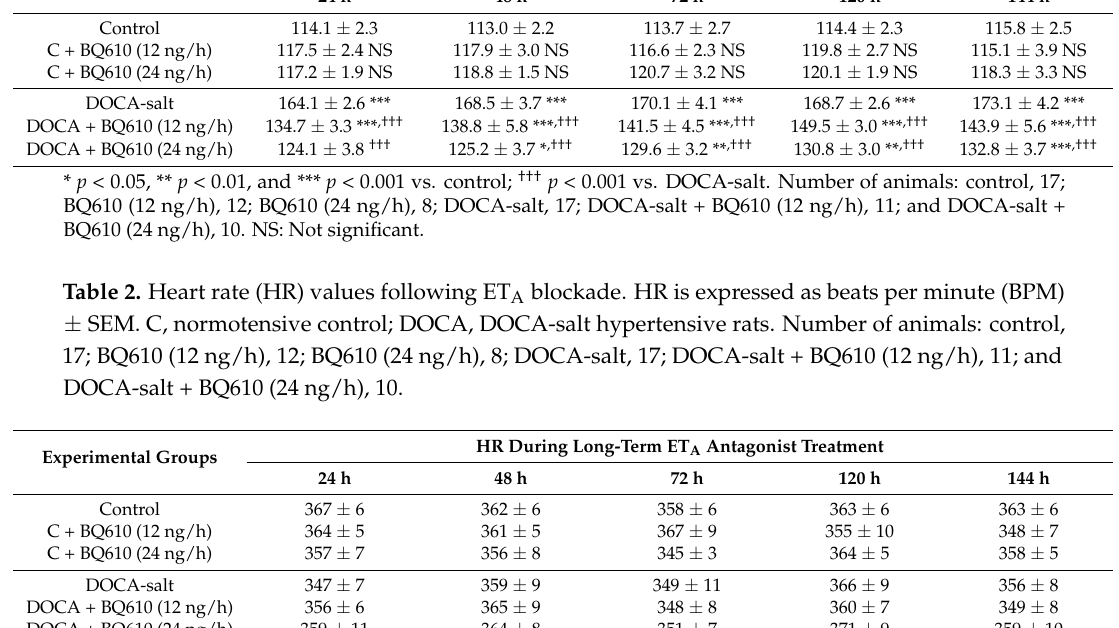
Figure 2. Heart rate (HR) following ET A blockade by BQ610 in both normotensive and DOCA-salt hypertensive rats. HR was assessed as detailed in Materials and Methods and expressed as beats per minute ± SEM. ( a ) Basal HR. Basal values were registered 48 h before BQ610 administration; ( b ) Time course of HR. HR was registered following BQ610 administration at 24, 48, 72, 96, 120, and 144 h; ( c ) Average HR. Each bar represents the area under each curve (shown in b ) between 0 and 144 h. Number of animals: control, 17; BQ610 (12 ng/h), 12; BQ610 (24 ng/h), 8; DOCA-salt, 17; DOCA-salt + BQ610 (12 ng/h), 11; and DOCA-salt + BQ610 (24 ng/h), 10. Table 2. Heart rate (HR) values following ET A blockade. HR is expressed as beats per minute (BPM) ± SEM. C, normotensive control; DOCA, DOCA-salt hypertensive rats. Number of animals: control, 17; BQ610 (12 ng/h), 12; BQ610 (24 ng/h), 8; DOCA-salt, 17; DOCA-salt + BQ610 (12 ng/h), 11; and DOCA-salt + BQ610 (24 ng/h), 10.